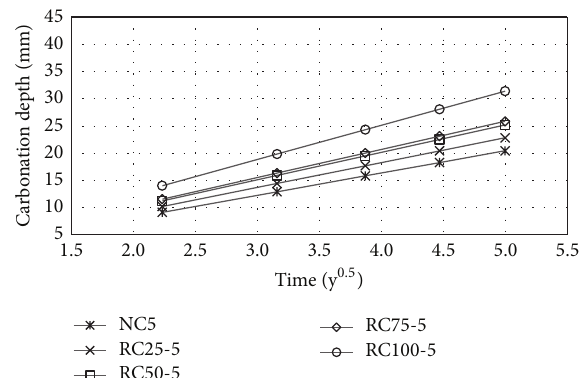
Figure 5: Calculated progress of carbonation depth versus time for 0.5 w/c.